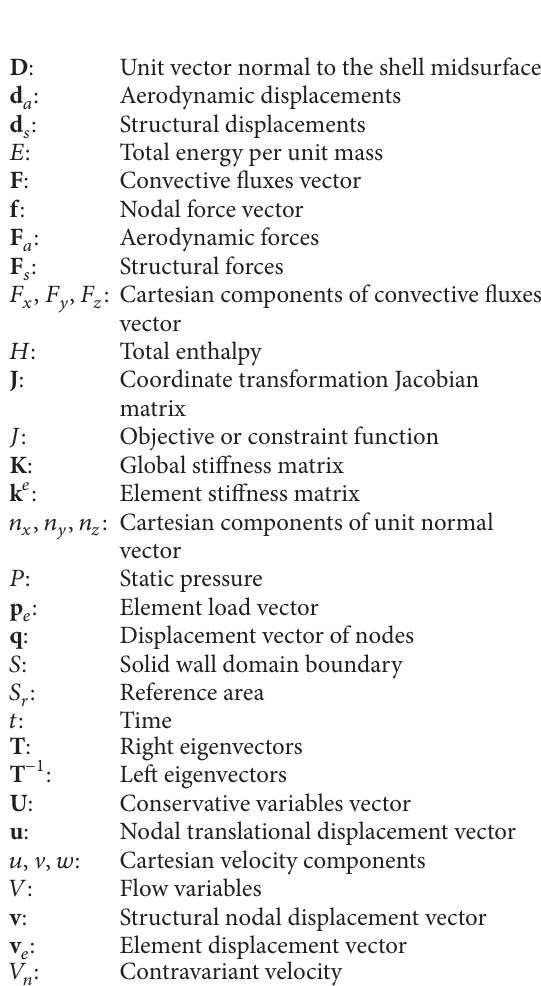
Figure 16: Comparison of section shapes before and after design of flexible wing.